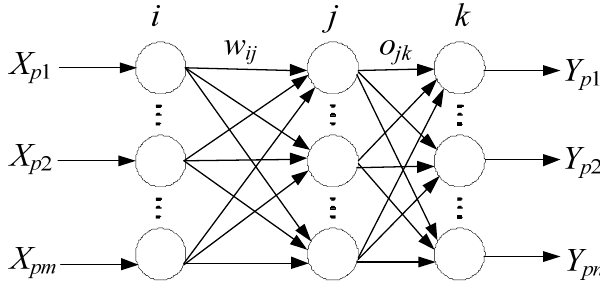
Figure 4. The topological structure of a three-layer BP neural